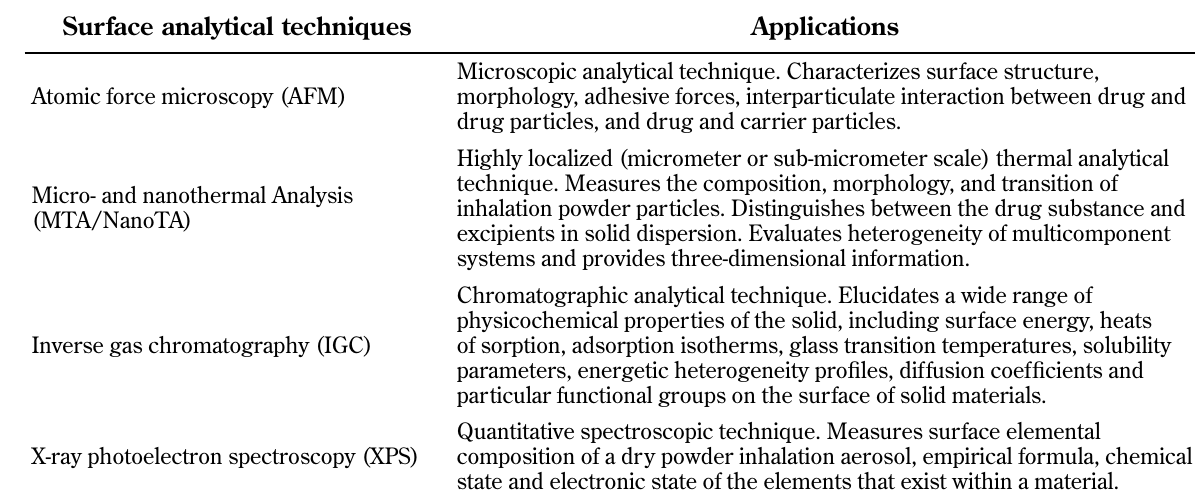
Table 2 Summary of surface analytical techniques as well as parameters accessible by them. Surface analytical